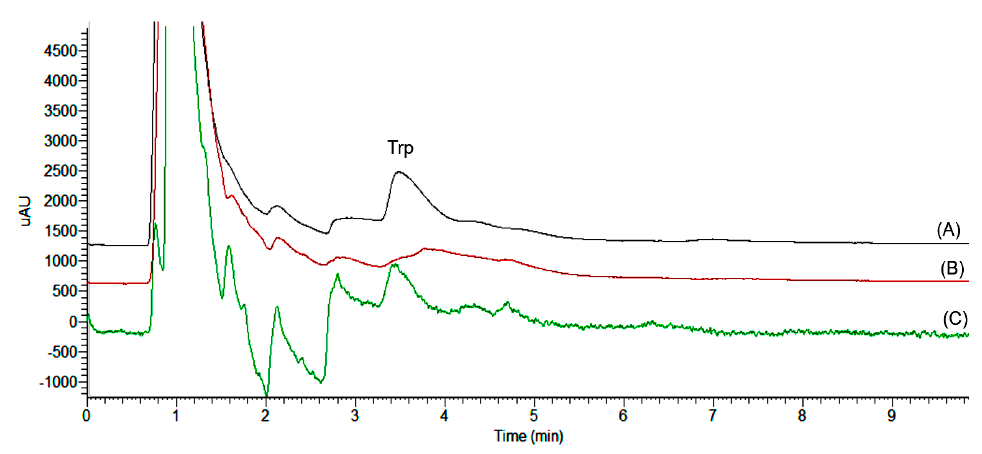
Figure 5. HPLC chromatograms of free tryptophan after RP − DLLME. ( A ) Matrix-matched standard Figure 4. HPLC chromatograms of free tryptophan after RP − DLLME. (A) Matrix-matched standard (20 mg/kg 100 g oil); ( B ) blank; and ( C ) almond oil sample. (20 mg/kg 100 g oil); (B) blank; and (C) almond oil